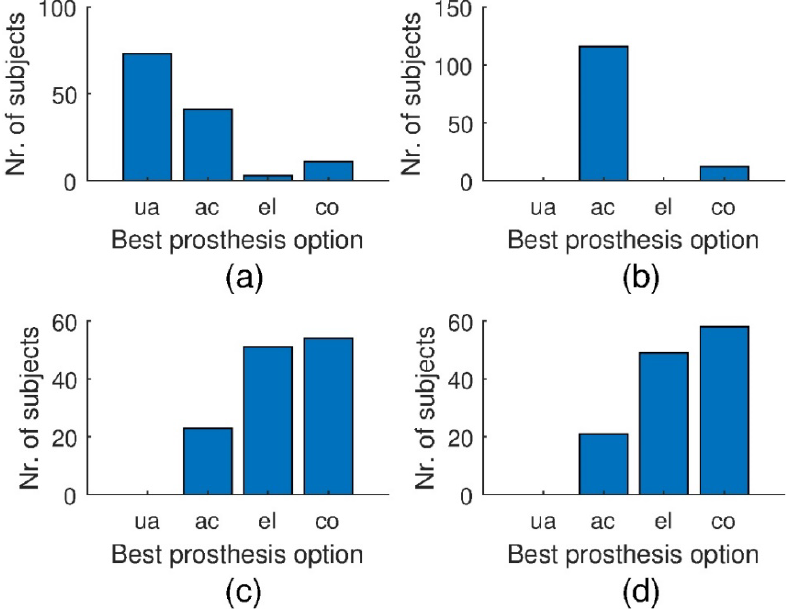
Figure 3. Numbers of subjects with regard to the individually predicted best hearing prosthesis, i.e., the prosthesis corresponding to the minimum cost-adjusted loss of action potentials (LAP) score. The types of hearing loss are as follows: ( a ) cochlear synaptopathy (CS), ( b ) cochlear gain loss (CGL) + CS, ( c ) loss of IHCs (IHCL) + CGL + CS, ( d ) IHCL + CGL + CS. The types of hearing prosthesis are as follows: unaided hearing (ua), acoustical amplification (ac), electrical stimulation (el), and el combined with ac (co).